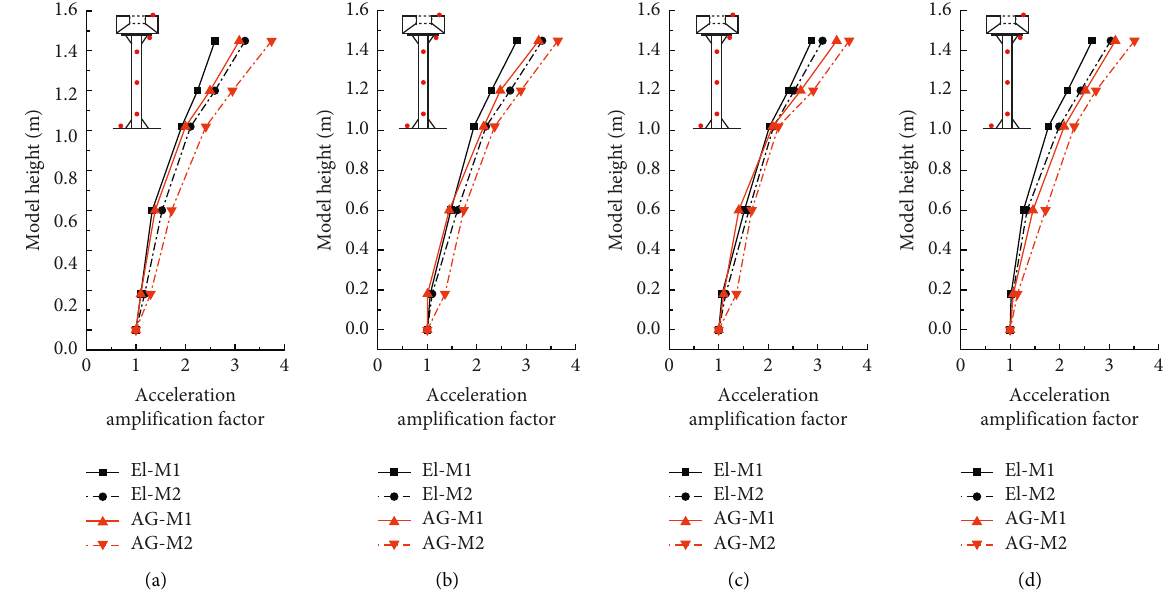
Figure 10: Comparison of acceleration amplification factors. (a) PGA of 0.10 g. (b) PGA of 0.15g. (c) PGA of 0.20g. (d) PGA of